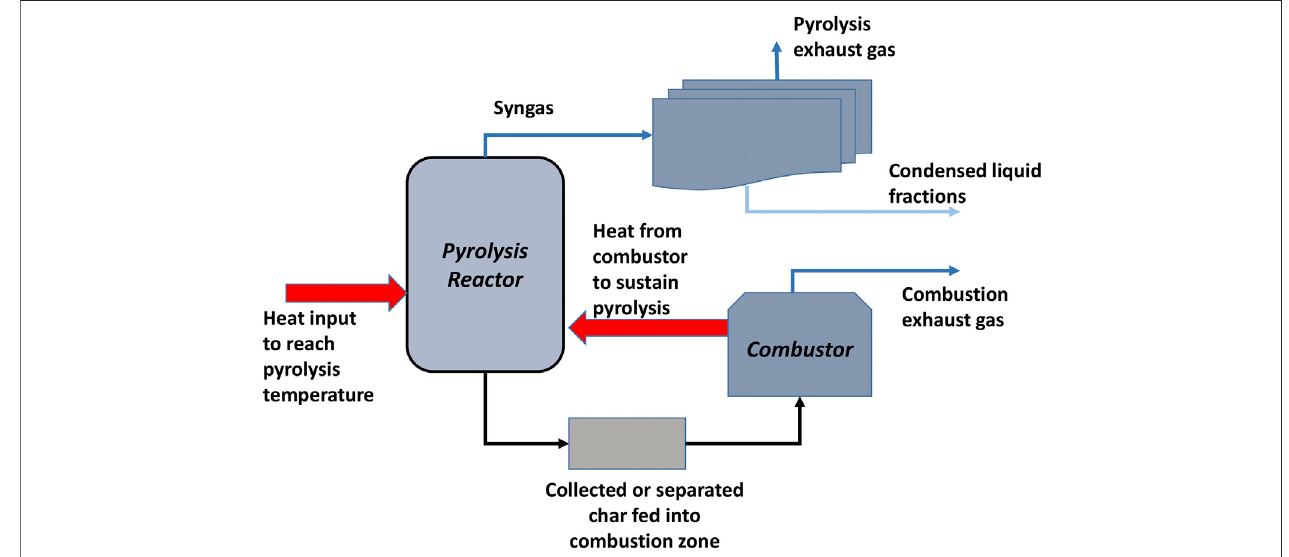
FIGURE 1 | General fl ow sheet for the pyrolysis process.